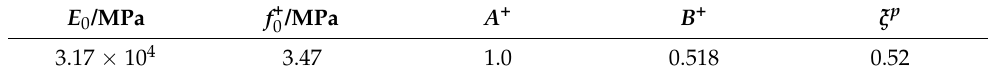
Table 4. Simulation parameters of the cyclic tensile test.